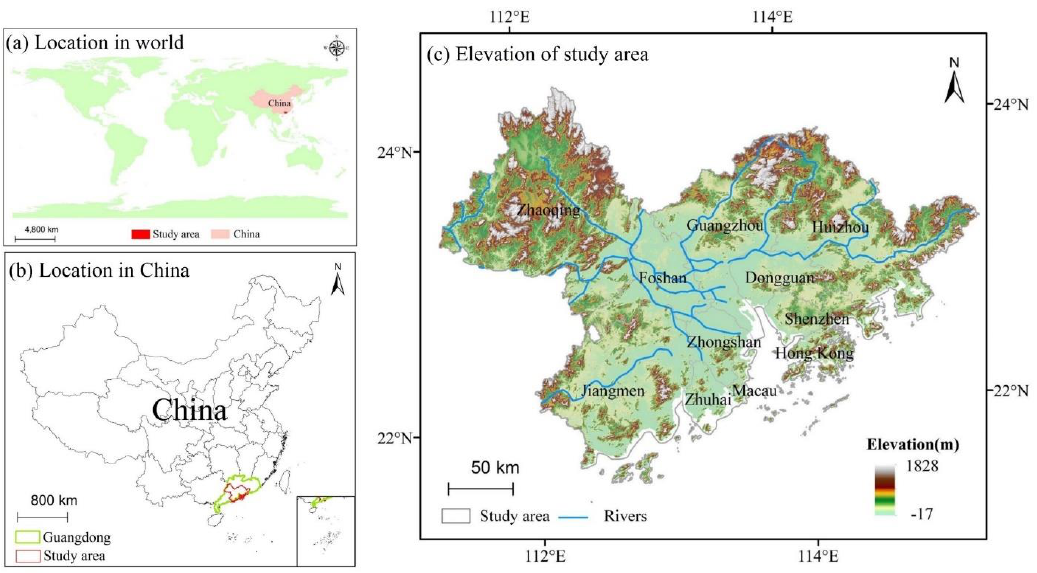
Figure 1. Location and elevation of the Guangdong–Hong Kong–Macao Greater Bay Area (GBA) in relation to ( a ) the world and ( b ) China, and ( c ) with elevation.